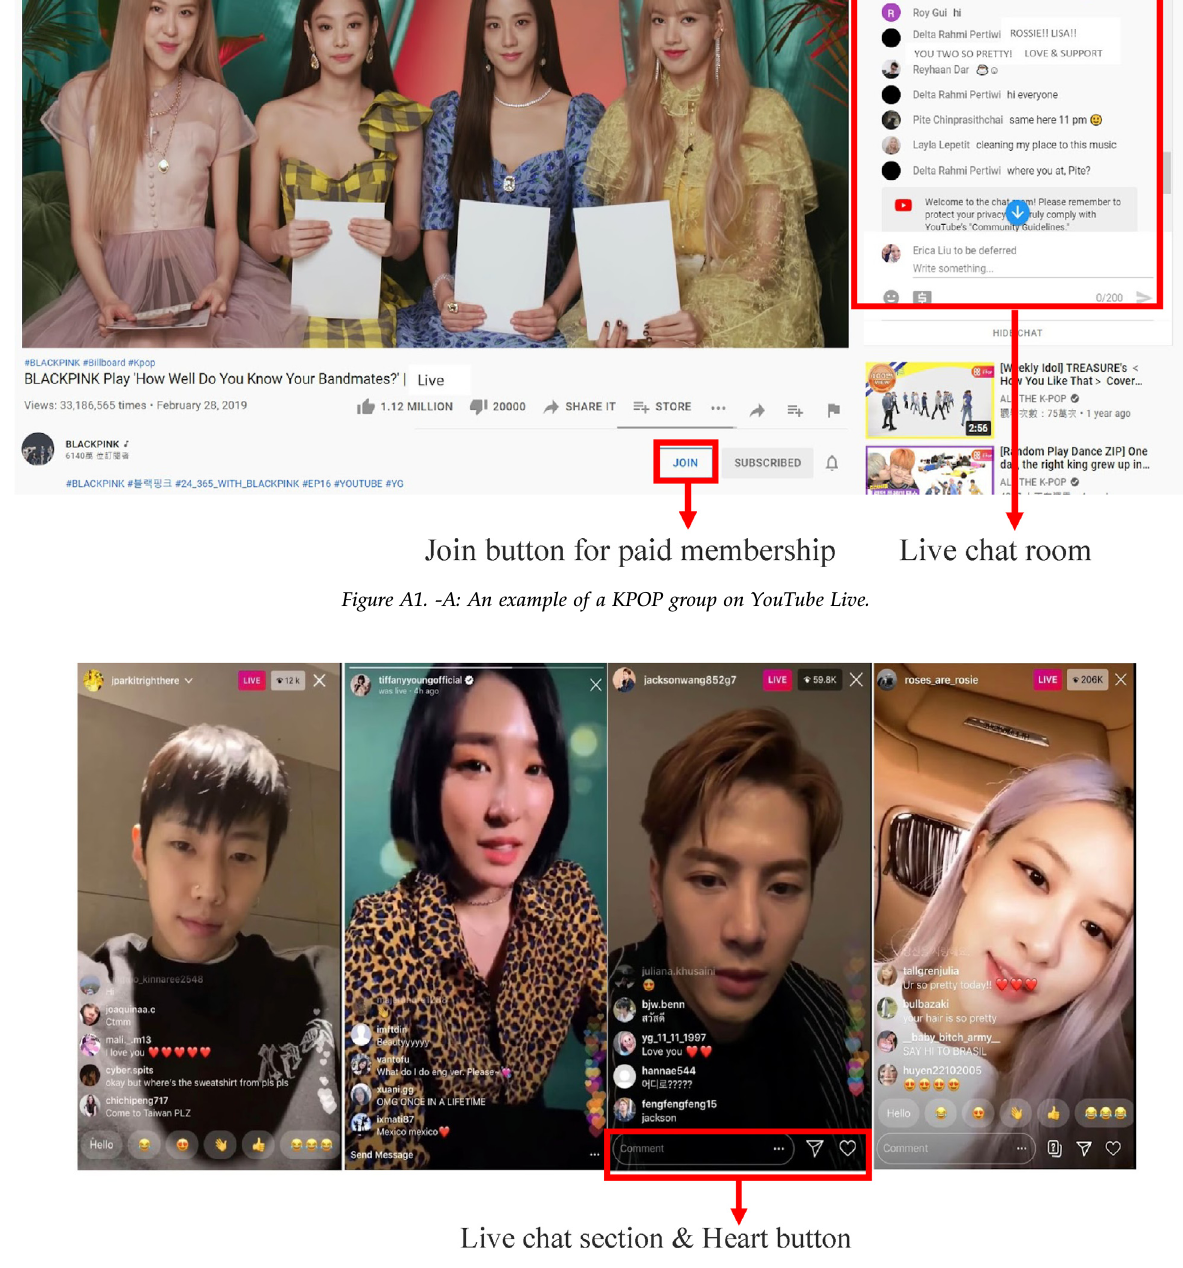
Figure A1. -B: An example of celebrities on Instagram